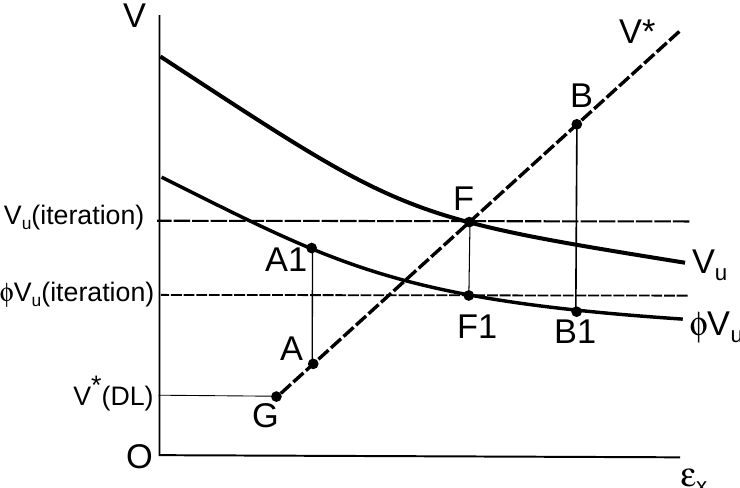
Figure 16. Adverse effects of finding ultimate shear using proportionally increased live load